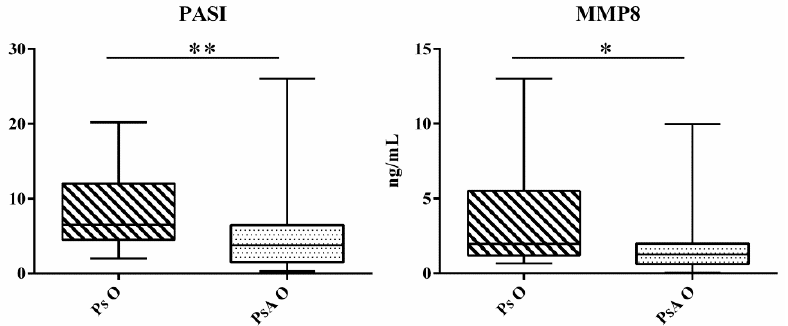
Figure 3. Changes in PASI and serum profile of MMP8 in Ps O group (hashed box) and PsA O group (dotted box). The box and whiskers plot identifies, respectively, the value of the median (intermediate line), the 25 th and 75 th percentile (box), and the minimum and maximum value (whiskers). Asterisks indicate significant intergroup differences (* p < 0.05, ** p < 0.01). MMP: Matrix metalloproteinasis, PASI: Psoriasis area severity index, Ps O: Psoriatic onychopathy, PsA O: Psoriatic arthritis with onychopathy.